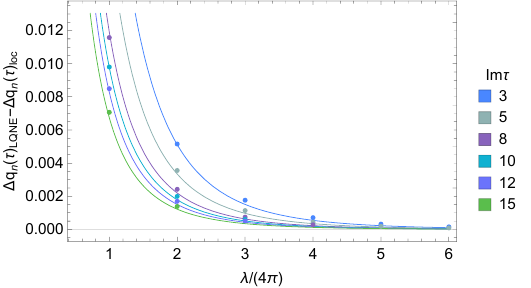
Figure 3 . Difference between the lqne prediction and the localization estimate for the first variation ∆ as function of λ/ (4 π ) = n/ Im( τ ) for fixed values of Im( τ ) (dots). The continuous lines are the n q n best numerical fit for the exponential correction k k 6 = 3 . 347(13)